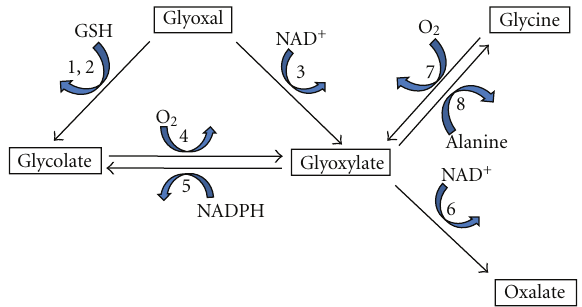
Figure 3: Potential mechanisms for oxalate synthesis from